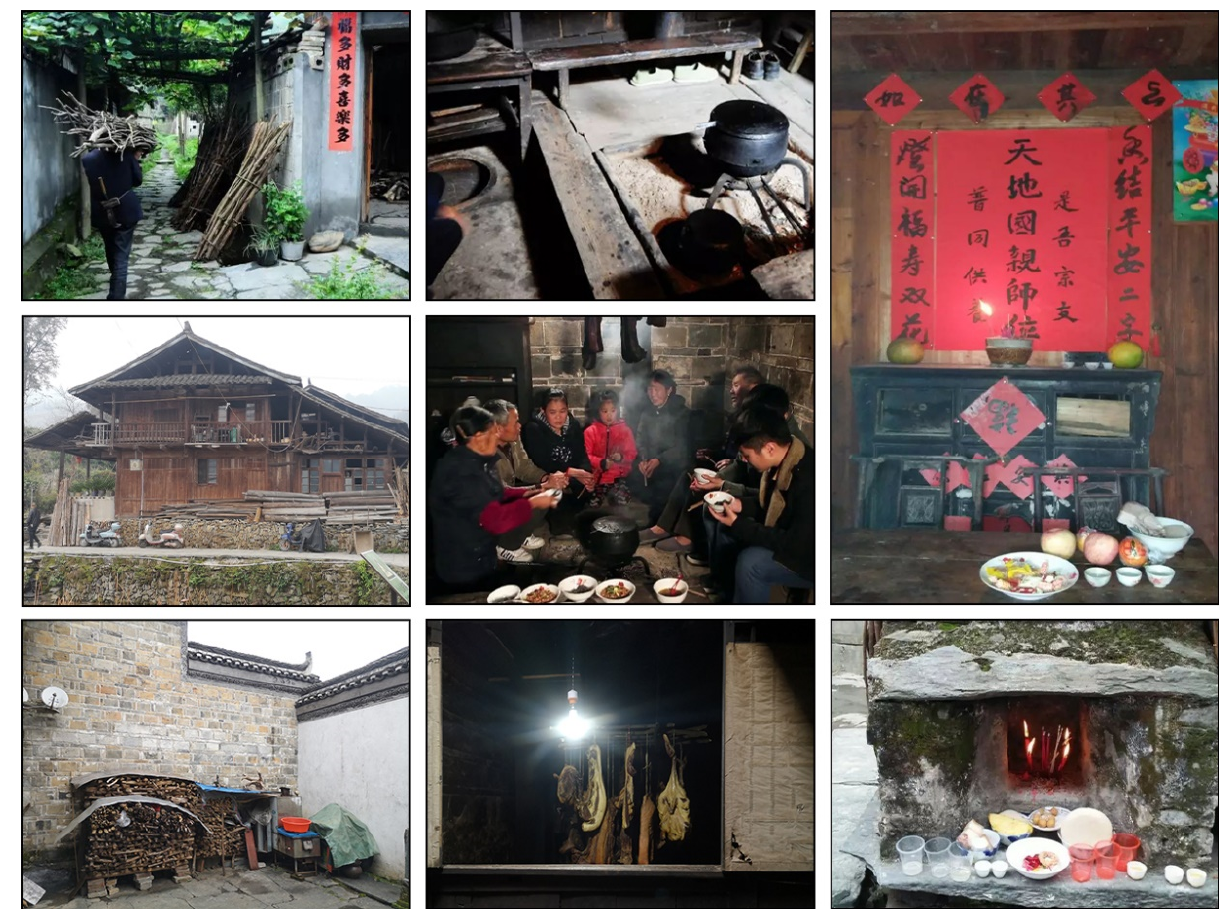
Figure 7. A selection of typical fire-related activities in High chair Village.